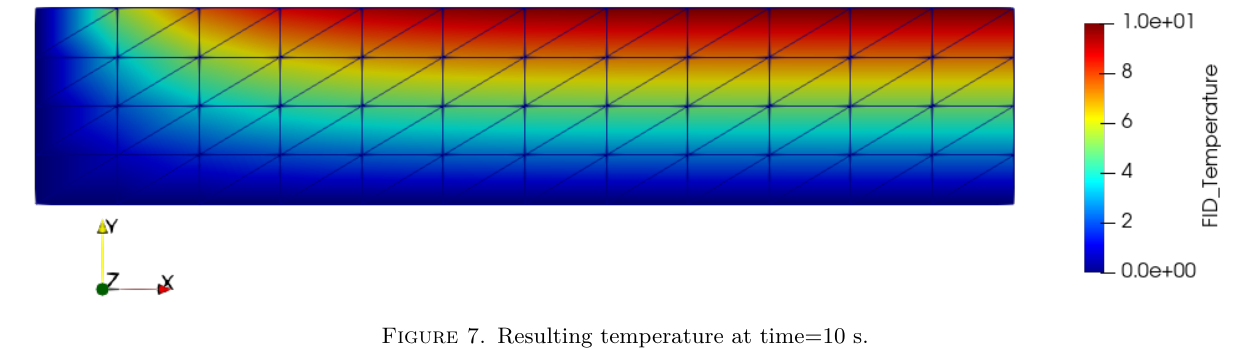
Figure 7. Resulting temperature at time=10 s.